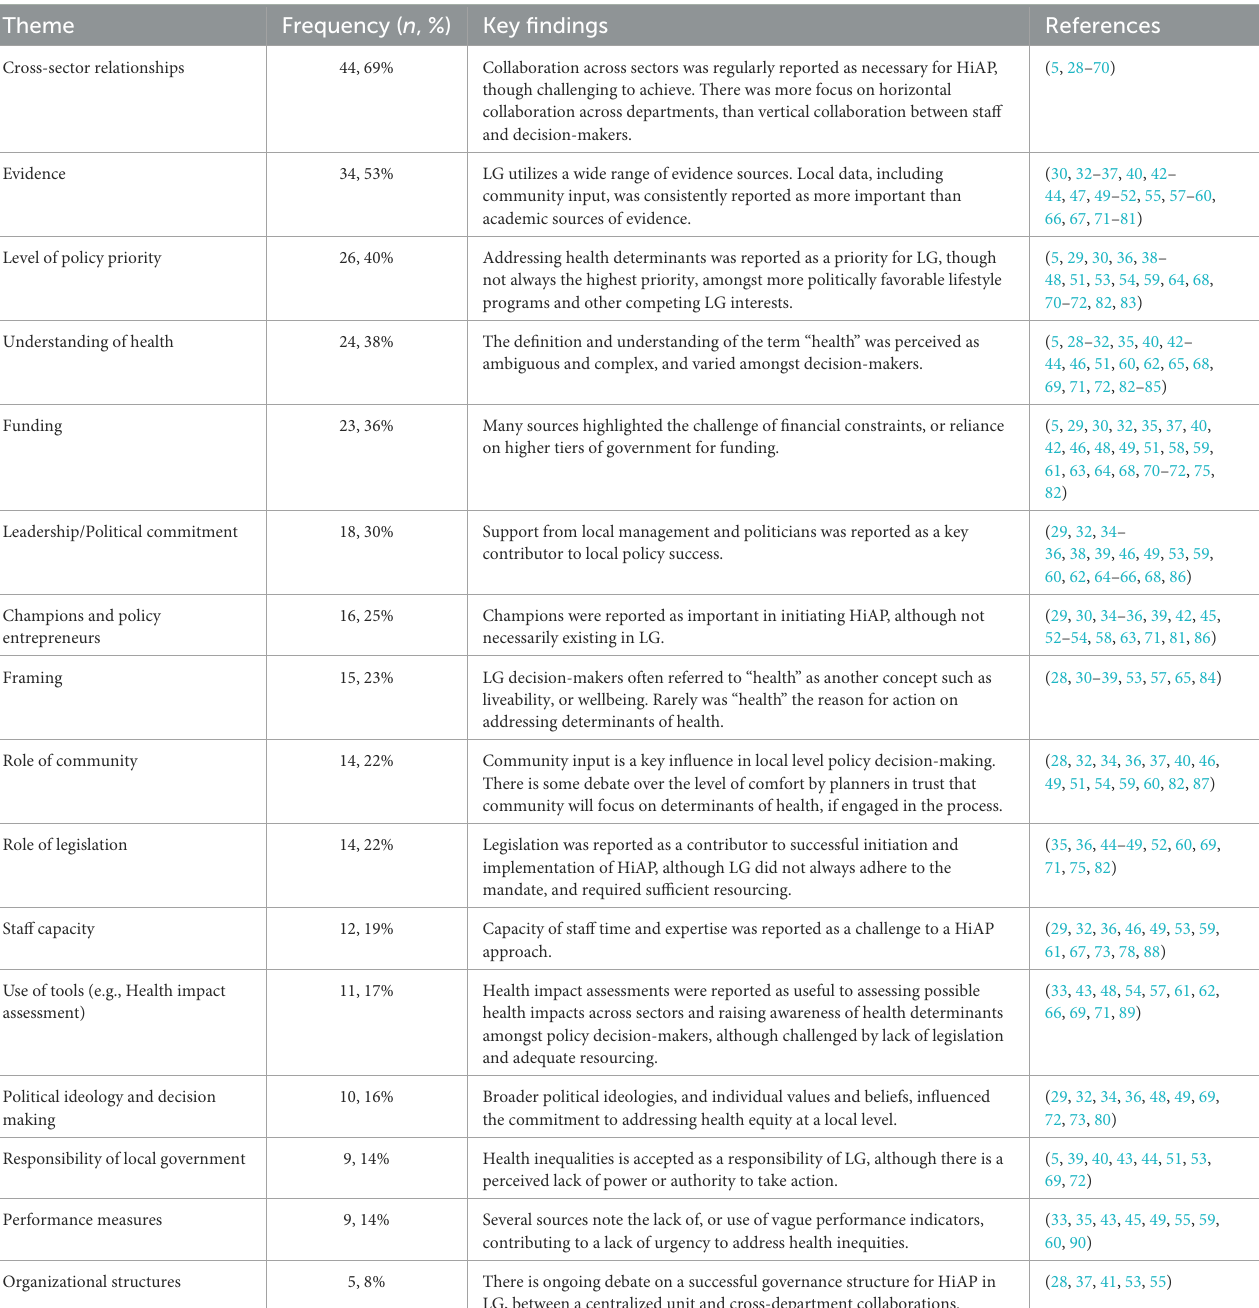
TABLE 3 Outline of the 16 identified factors influencing HiAP within LG, with a summary of the key findings (review, global,